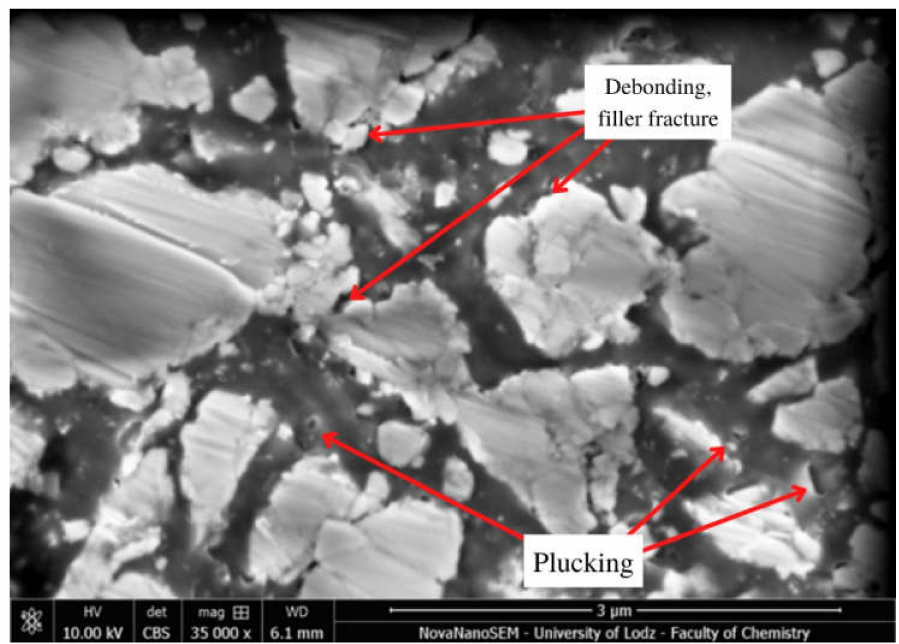
Figure 5. Scanning electron microscopy (SEM) micrograph of Flow-Art at 35,000 × magnification after Protocol 5 (one week, 60 ◦ C, 0.1 M